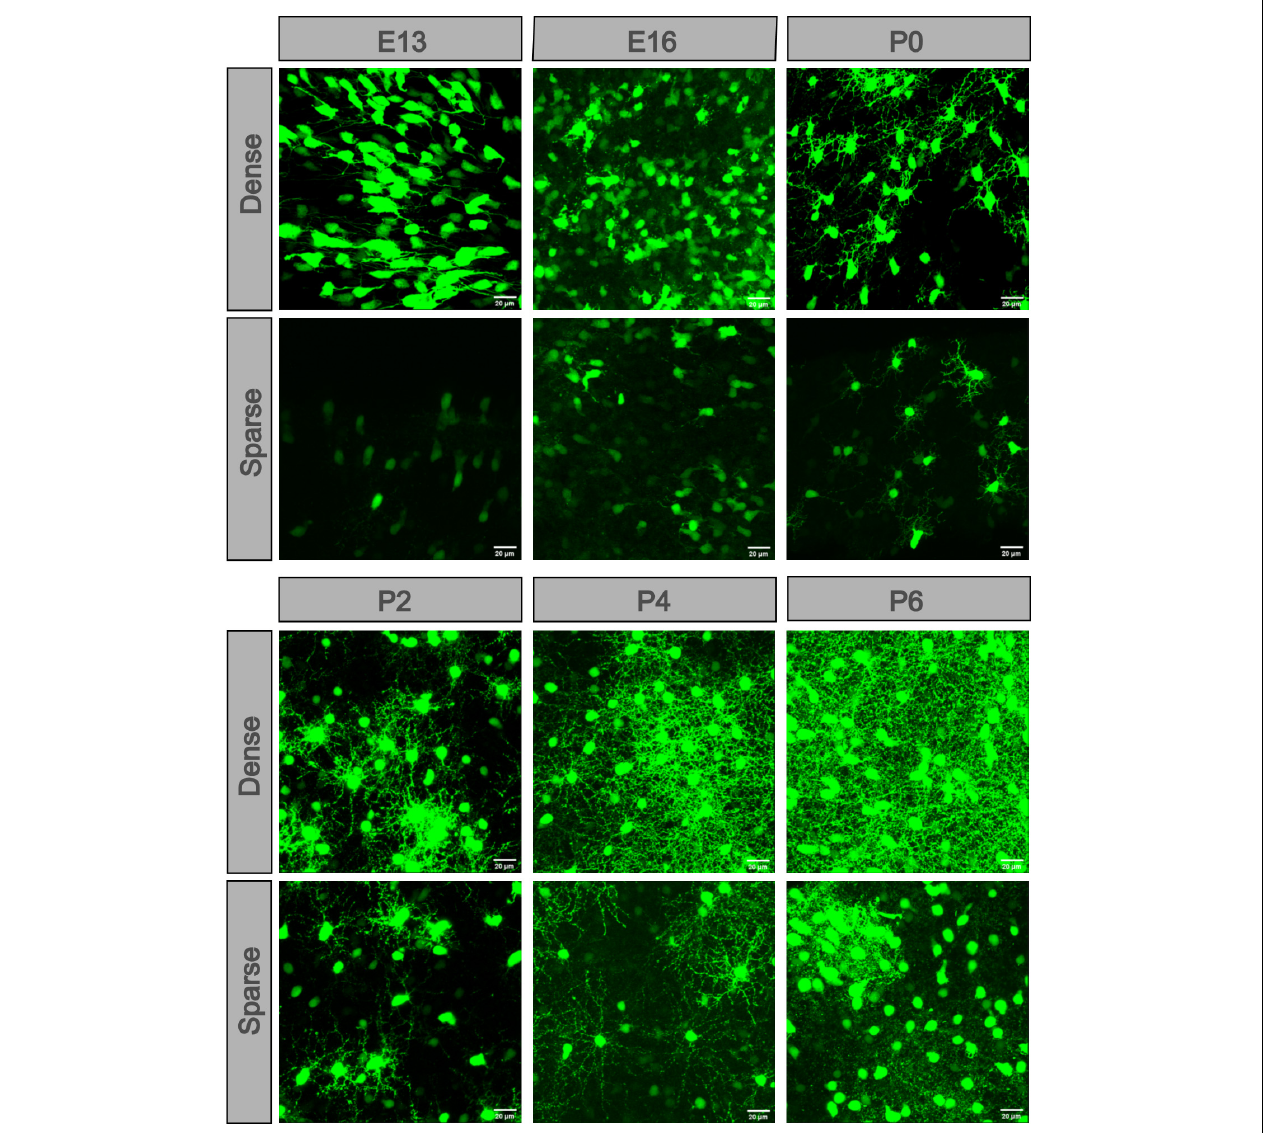
FIGURE 4 | POMC-positive cells developed at different levels in different retinal areas. In each retina, cells located in the dense part were more developed. Dendrites appeared at P0 and then overlapped at P2. The more developed cells were separated by less developed cells. At P8, the dendrite net was throughout the full field. Bar = 20 µ